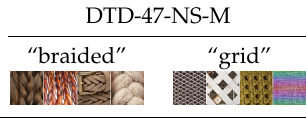
Figure 10. Group #10: Non-stationary textures acquired under multiple variations in the imaging conditions (Section 3.2.10).